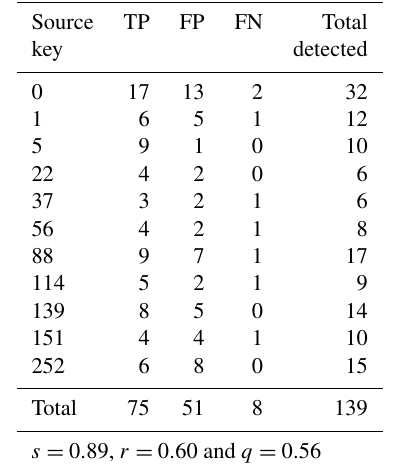
Table 3. Accuracy metrics for calibration site II (Ribeirão Caraça basin, Caraça Range, QF,